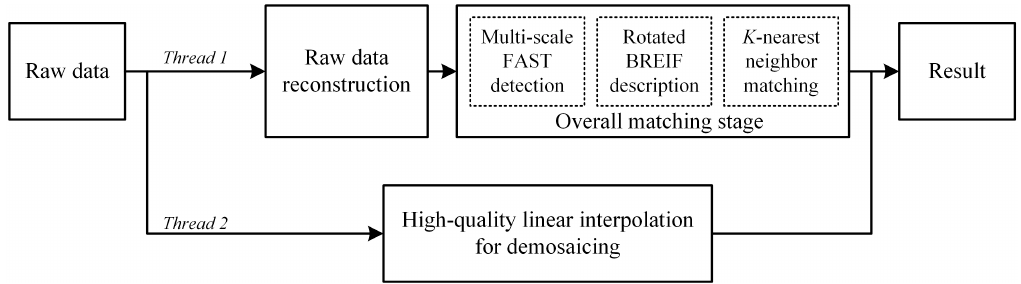
Figure 2. Flow chart of PIMR.